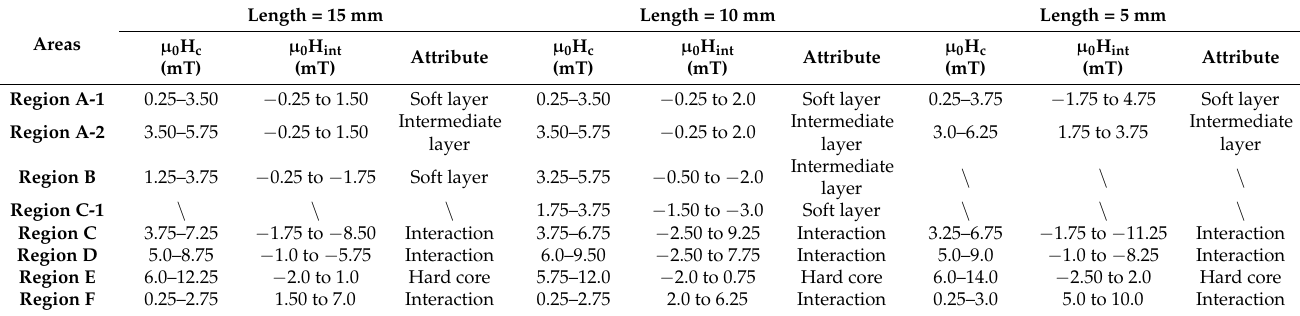
Table 1. Attribute statistics of various areas in each FORC